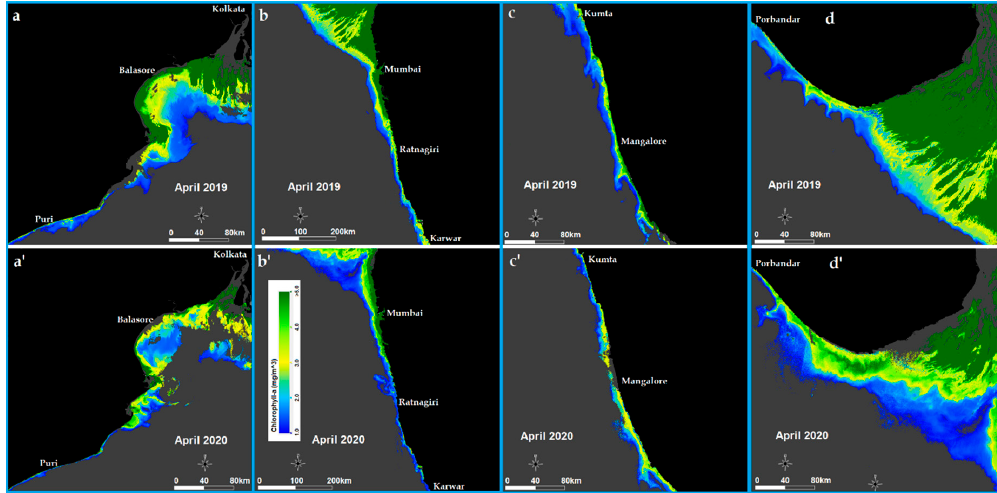
Figure 2. Region-wide comparison of the mean chlorophyll-a concentration between April 2019 (top row)-April 2020 (bottom row): ( a,a | ) Kolkata to Puri (East Coast- Bay of Bengal), ( b,b | ) Mumbai to Karwar (West Coast- Arabian Sea), ( c,c | ) Karwar to Kollam (Southwest Coast- Arabian Sea), ( d,d | ) Porbandar to Mumbai (West Coast- Arabian Sea).